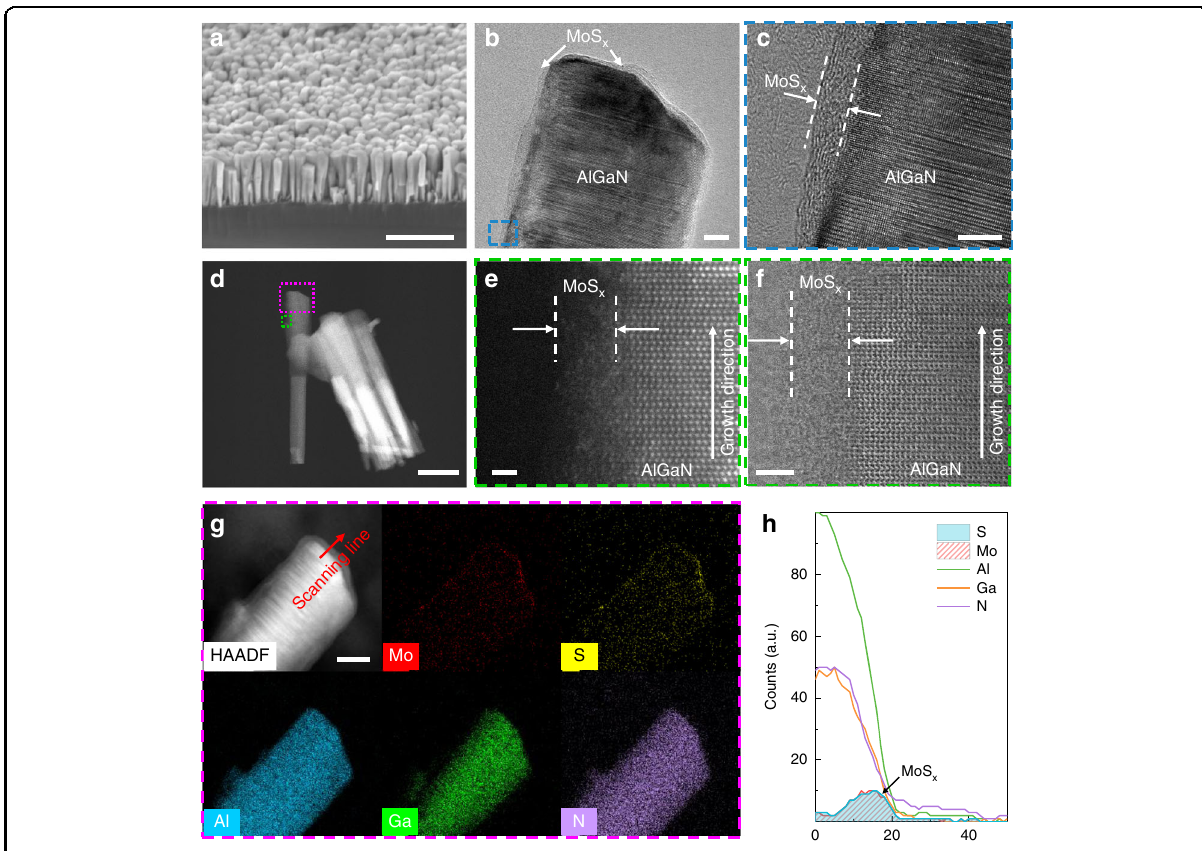
Fig. 2 Structural characterization of the a-MoS x -decorated p-AlGaN/n-GaN nanowires. a SEM (scale bar = 500 nm), b low-magni fi cation TEM (scale bar = 10 nm) and c high-resolution TEM images (scale bar = 5 nm), where a core-shell nanostructure can be clearly observed. The white dotted lines indicate the boundary of crystalline p-AlGaN core and amorphous MoS x shell. d Low-magni fi cation STEM (scale bar = 100 nm), e high-angle annular dark- fi eld (HAADF) (scale bar = 1 nm), and f annular bright- fi eld (ABF) STEM images of a-MoS x -decorated p-AlGaN/n-GaN nanowires (scale bar = 2 nm), showing the polymer nature of a-MoS x . g STEM-EDS elemental mapping (scale bar = 30 nm) and h line pro fi ling showing the abruptness interface between a-MoS x and p-AlGaN